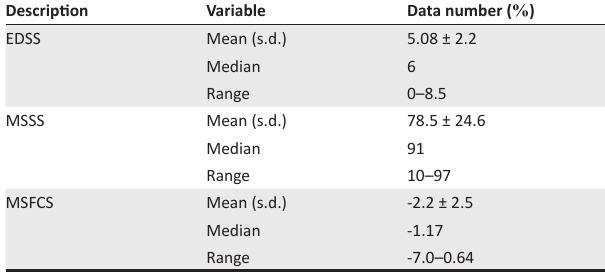
TABLE 2: Measures of disability in patients with multiple sclerosis.